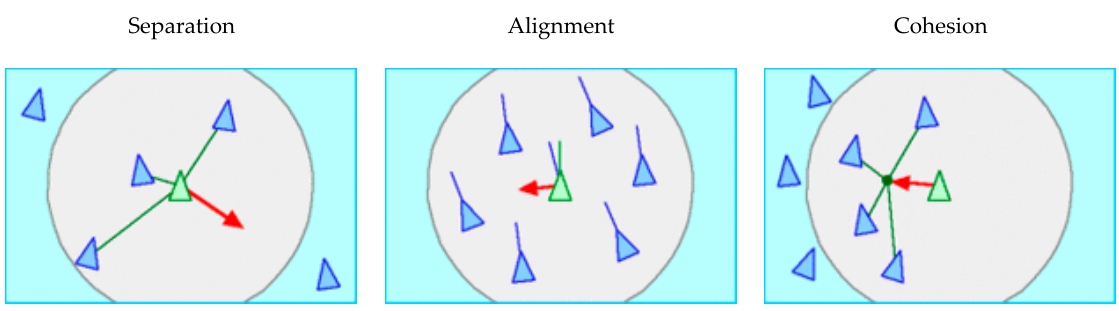
Figure 1. Three major parameters in a swarm. Sources: https://en.wikipedia.org/wiki/Boids.